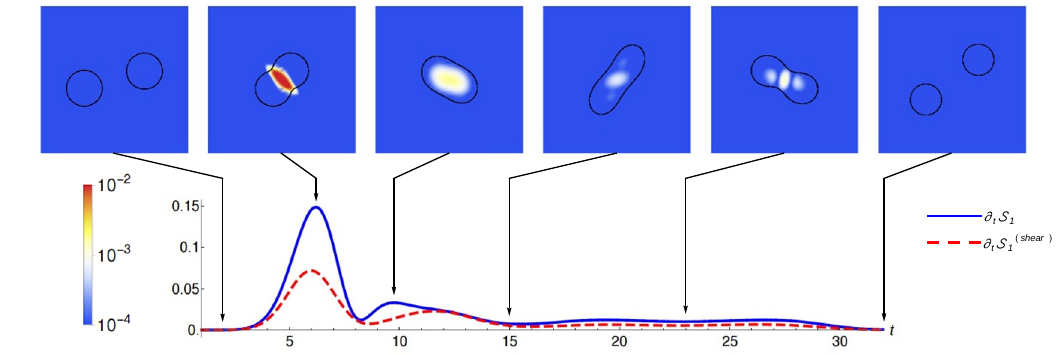
Figure 8 . Entropy production during a collision with fusion followed by (cid:12)ssion. The entire process can be divided in three stages: t (cid:25) 4 to 8, fusion; t (cid:25) 9 to 14, quasi-thermalization into a bar; t (cid:25) 15 to 30, (cid:12)ssion of the bar, similar to black string decay.